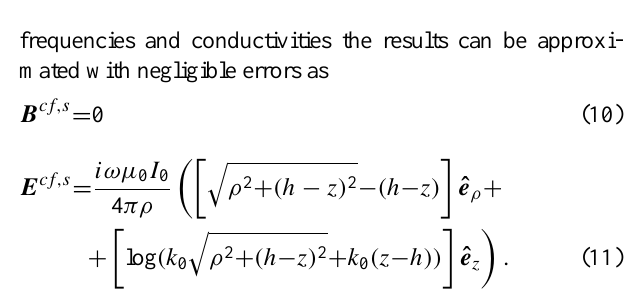
Fig. 2. The driving electric field and associated currents of the WTS